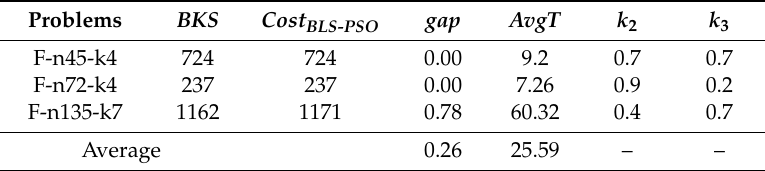
Table 7. Performance of BLS-PSO in solving the benchmark problems in Set F.